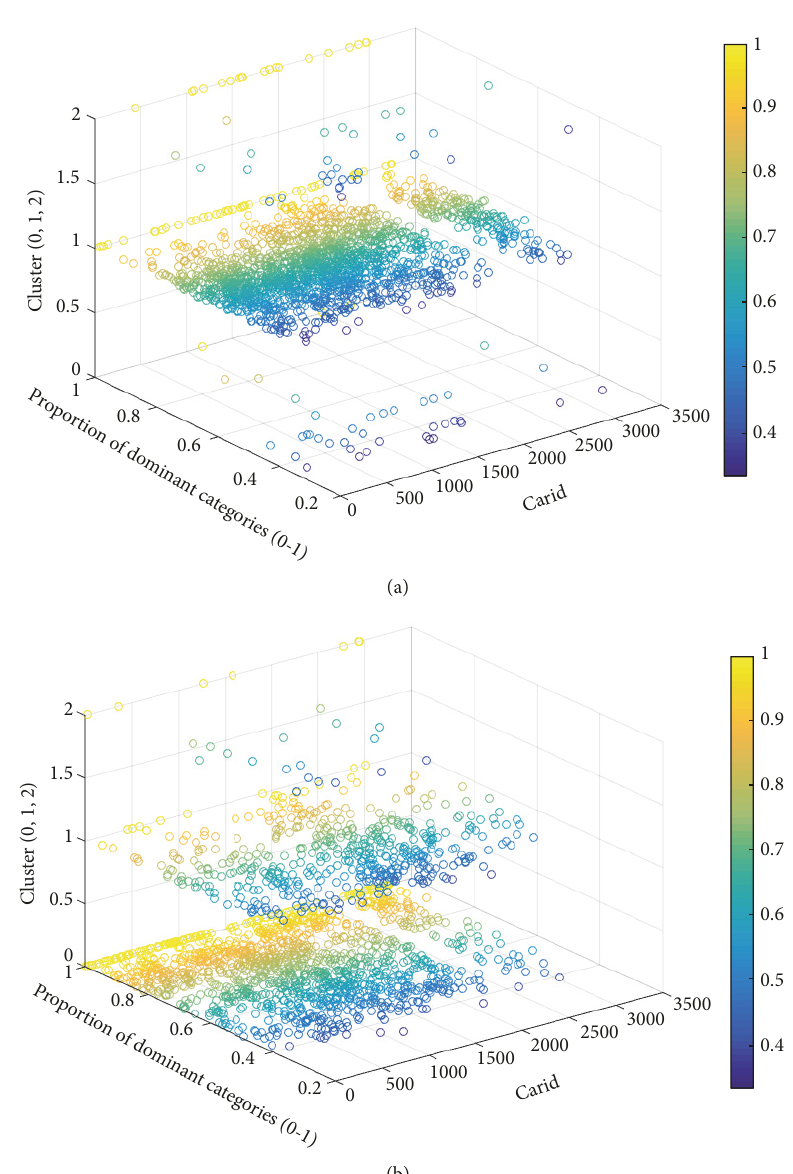
Figure 4: Statistical analysis of car-following data for each vehicle in (a) unblocked traffic state and (b) congested traffic